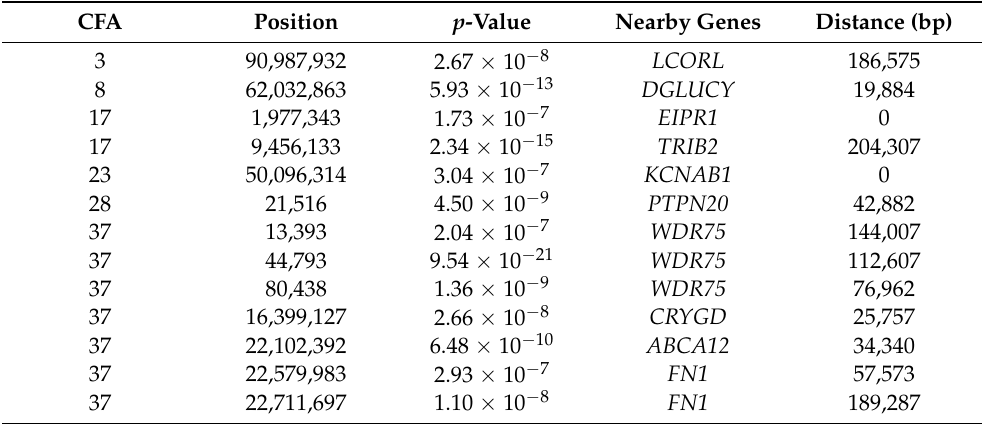
Table 2. Significantly associated SNPs above Bonferroni significance threshold